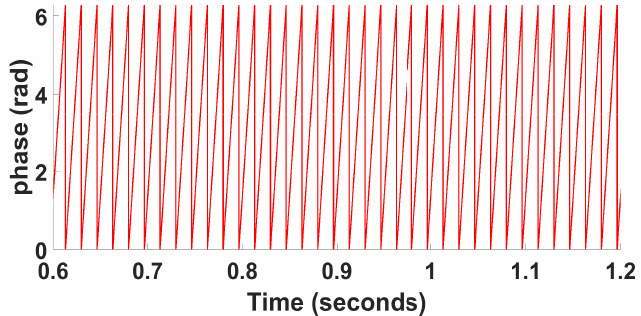
Figure 11. Grid position during voltage sag under the presence of the 5th